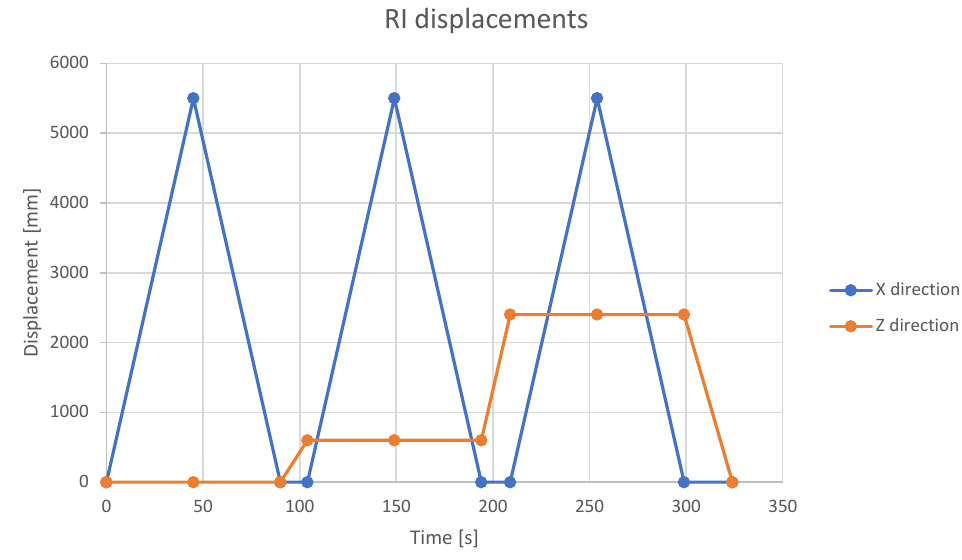
Figure 10. Schematic representation of the trajectories of the robot along the x (in blue) and the z (in orange)